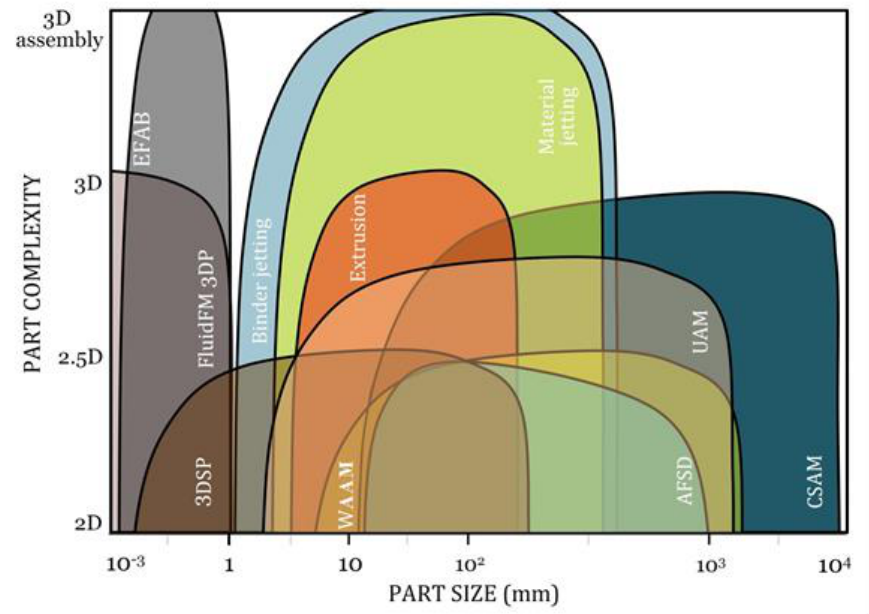
Figure 13. Comparison of the key beamless metal AM systems in terms of part complexity and size. EFAB, 3DSP, FluidFM 3DP are suitable for micro-scale applications. Binder jetting is a scalable process that can be used for micro to medium size parts while material jetting and extrusion methods are normally used for medium size parts. In contrast, CSAM, AFSD, UAM, and WAAW are more suitable for medium to mega-scale parts.